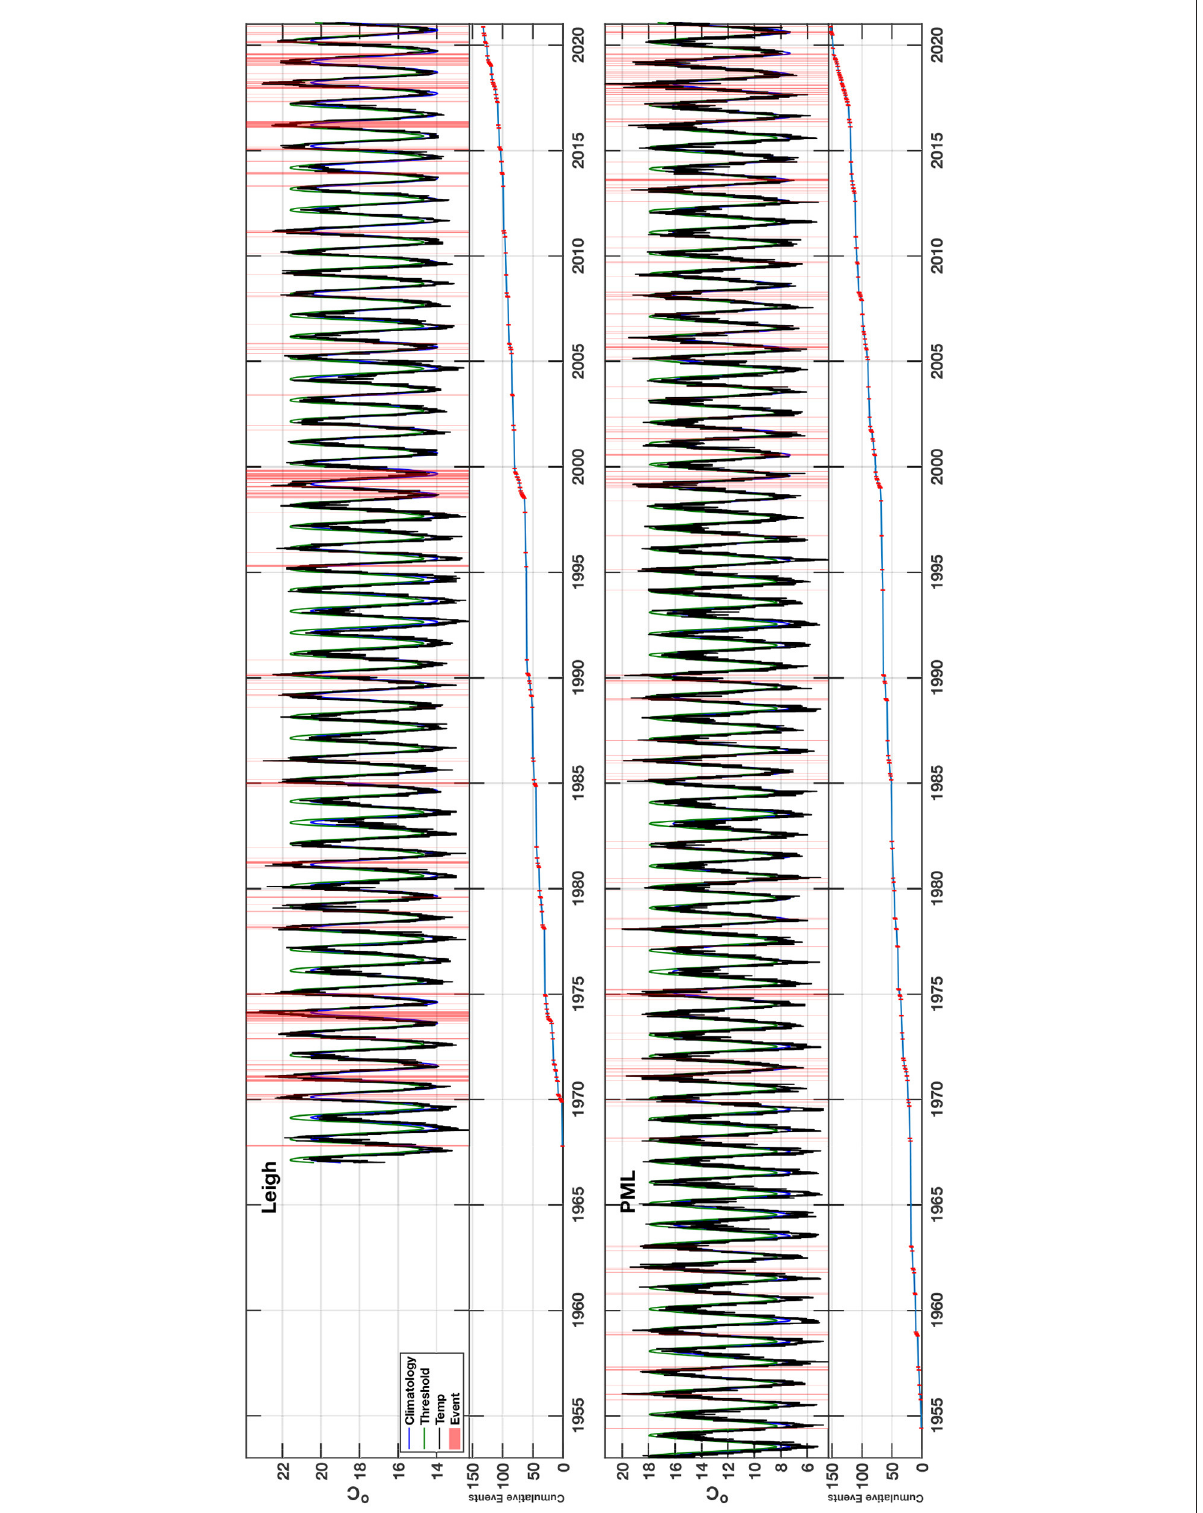
FIGURE3 Sea surface temperature (black) at Leigh and PML with climatology (blue), 90th percentile climatology (green) and detected MHW events (red highlight). Cumulative total of MHW events is displayed below both time-series with detected events illustrated as red vertical lines. Figures were produced using code modified from Zhao and Marin